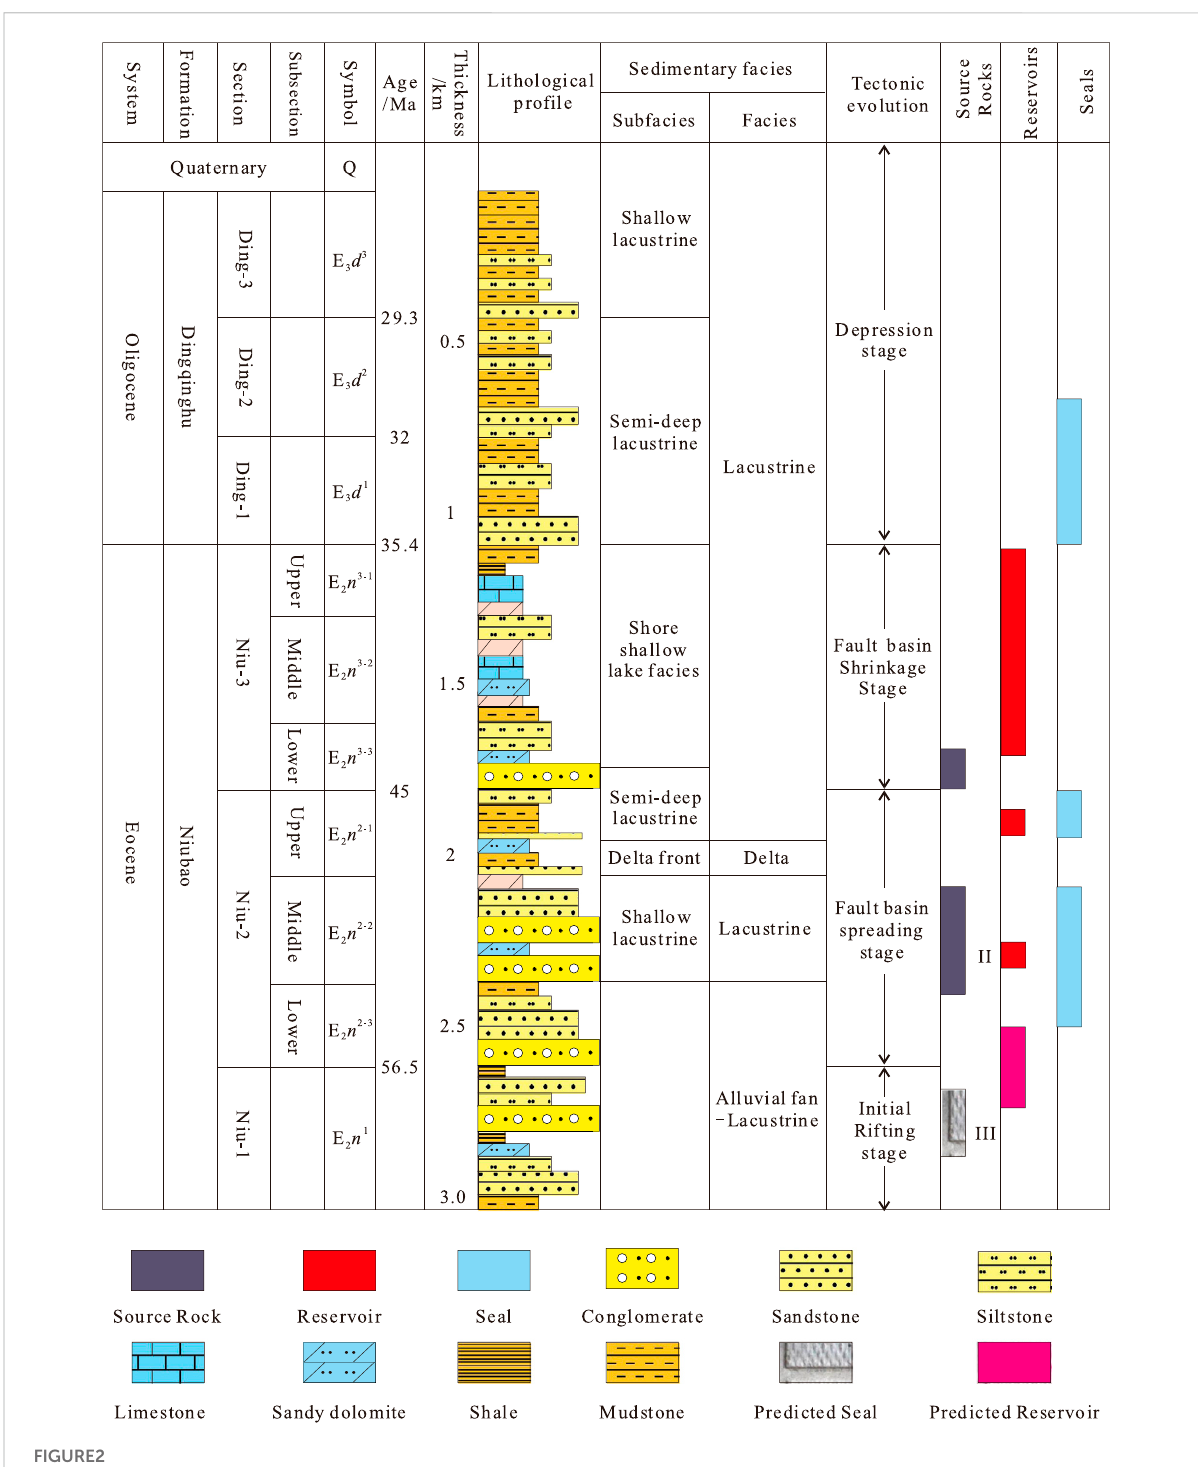
FIGURE2 The comprehensive histogram of the Lunpola